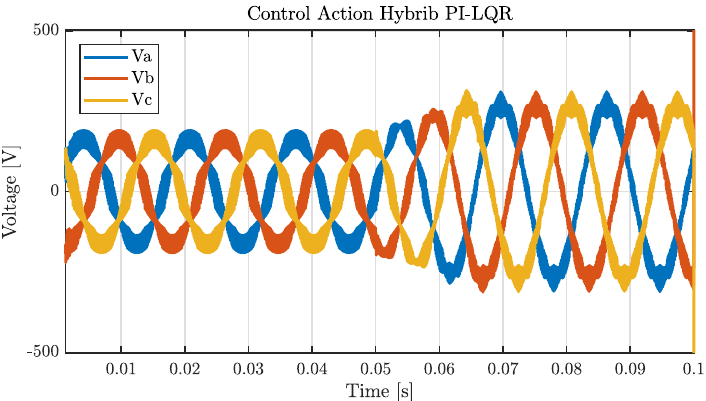
Figure 5. Illustrative voltage control action of the hybrid PI-LQR